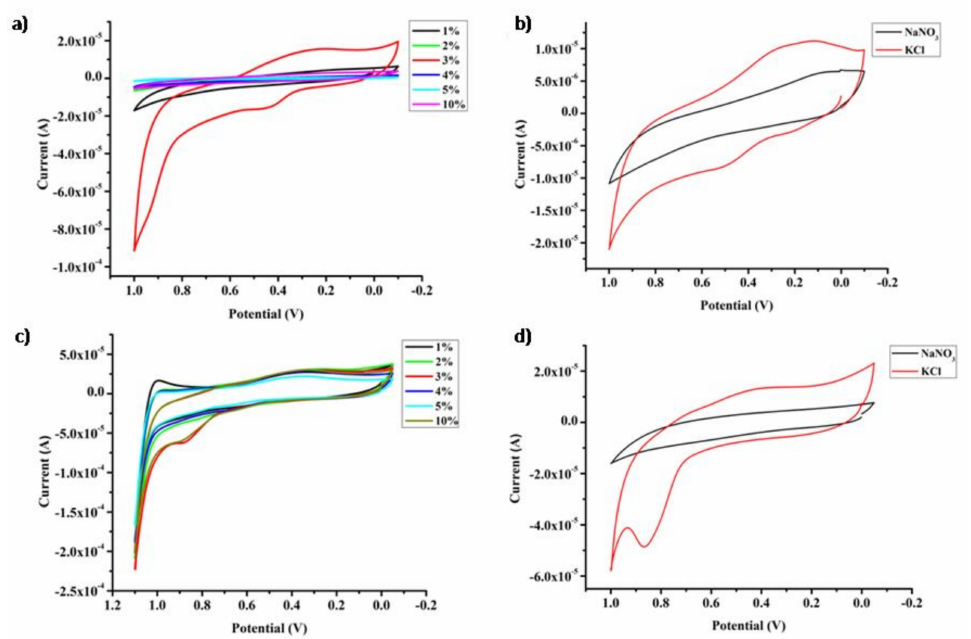
Figure 3. The Cyclic voltammogram of di ff erent percent composition of CNO in CNOs–PS / Pt-modified electrode in 0.5 M KCl solution in the presence of 10 − 2 Mat at a scan rate of 0.1 V / s ( a ) Cys, ( c ) Met; ( b , d ) are the Cyclic voltammogram of di ff erent supporting electrolyte for Cys and Met,